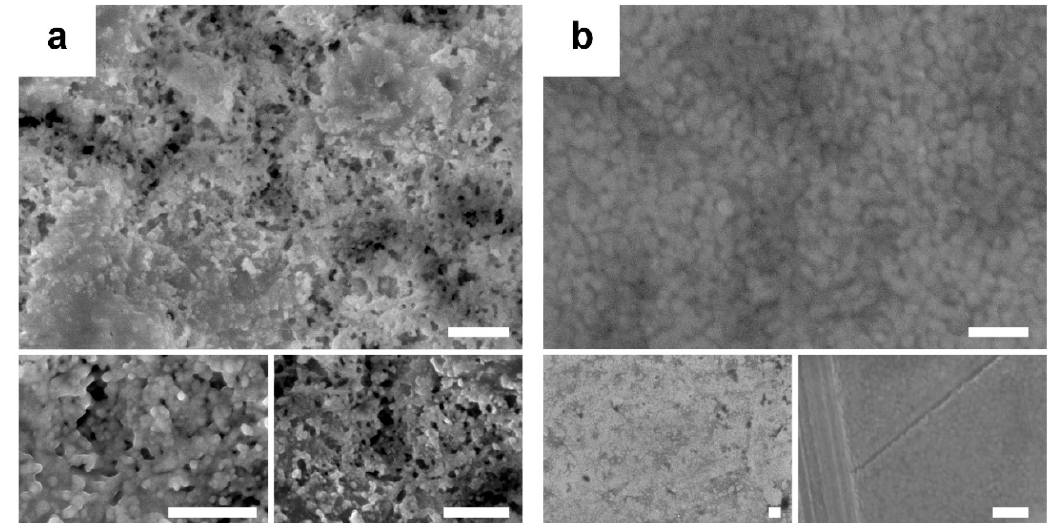
Figure 2. FE-SEM micrographs at different magnifications of the deposits obtained using the THF (Bath 1) solution on ( a ) FTO-coated glass and ( b ) Si/Ti/Au substrates at − 1.3 V (vs. Ag|AgCl) after circulating 7.5 C cm − 2 . Scale bar: 300 nm.